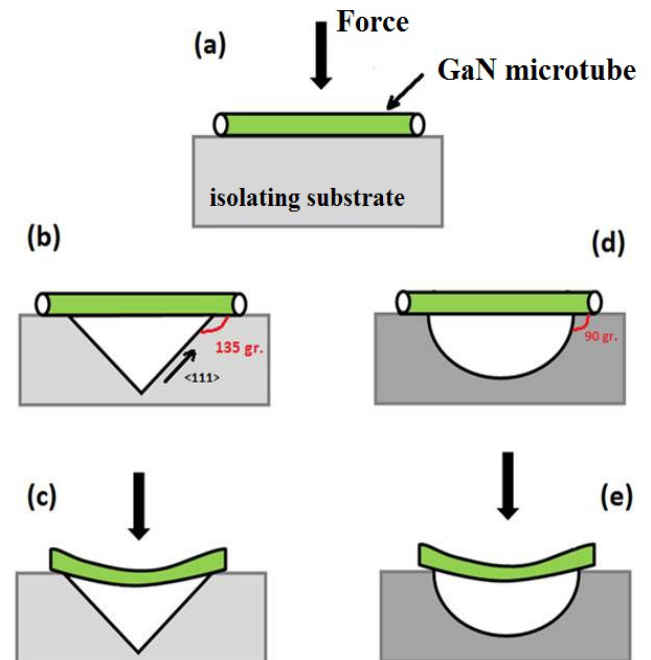
Figure 2. Schematic representation of the application of mechanical stress to a tubular sample. The cross-section of the substrate developed with a “V” shaped channel (b, c) and the optimized version with a semicircle “C” channel (d,